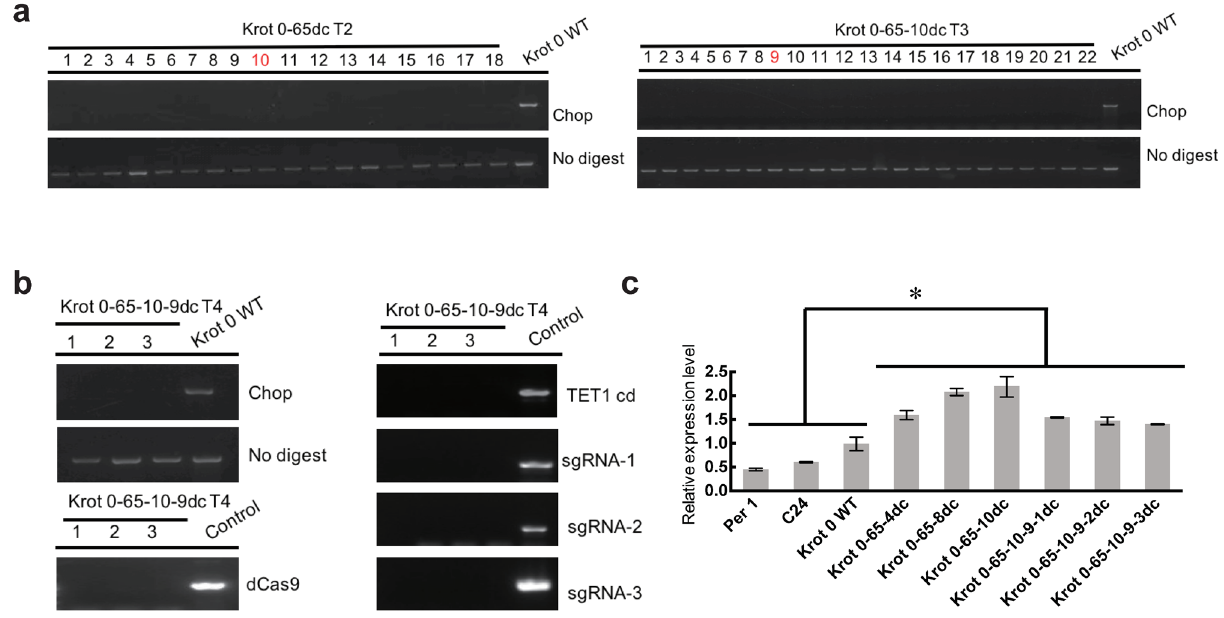
Figure 2. Multiple-generational inheritance of the epi-edited Krot 0-65dc. ( a ) Chop-PCR analysis of plants from T2 and T3 generations. The red numbers indicate the lines used in the experiment; ( b ) T4 generation without CRISPR/dCas9-TET1cd vector, the left is the results of T4 generation detection Chop-PCR and without dCas9, and the right is the T4 generation detection without TET1cd and sgRNAs. ( c ) PPH gene expression in Per 1, C24, Krot 0 WT (Krot 0 wild type), T2, and T4 generations ( n = 3, *, p < 0.05, t